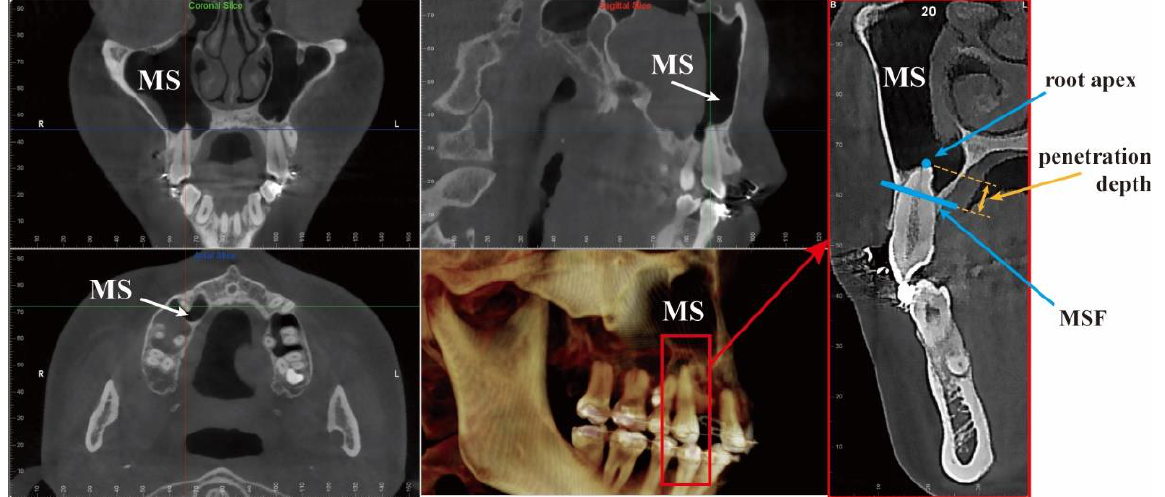
Figure 1. Tomography images of a patient with a low MSF. Penetration depth is the distance between the root apex and the MSF; MS is the maxillary sinus; MSF is the maxillary sinus floor. Three types of teeth were analyzed, including a canine, a double-rooted premolar, and a molar with three roots. The lengths of the teeth (i.e., the long axis) were 23.41 mm, 19.70 mm, and 19.43 mm, respectively. Their shapes and sizes are shown in Figure 2.